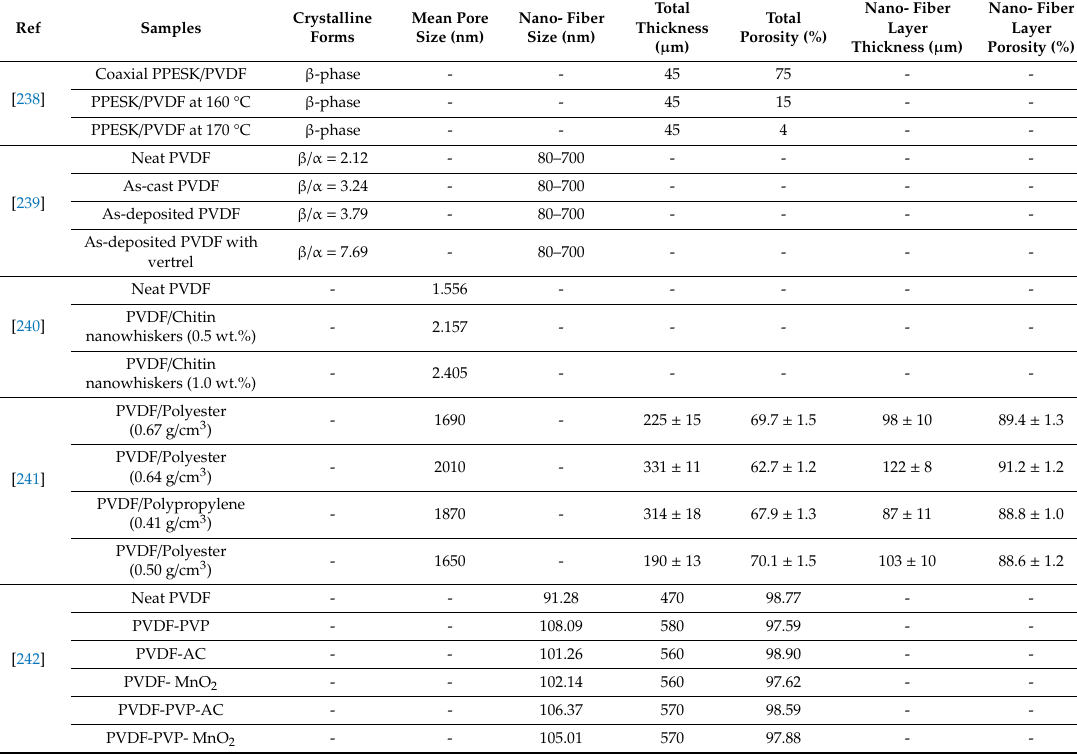
Table 9. Examples of PVDF membranes produced via electrospinning.